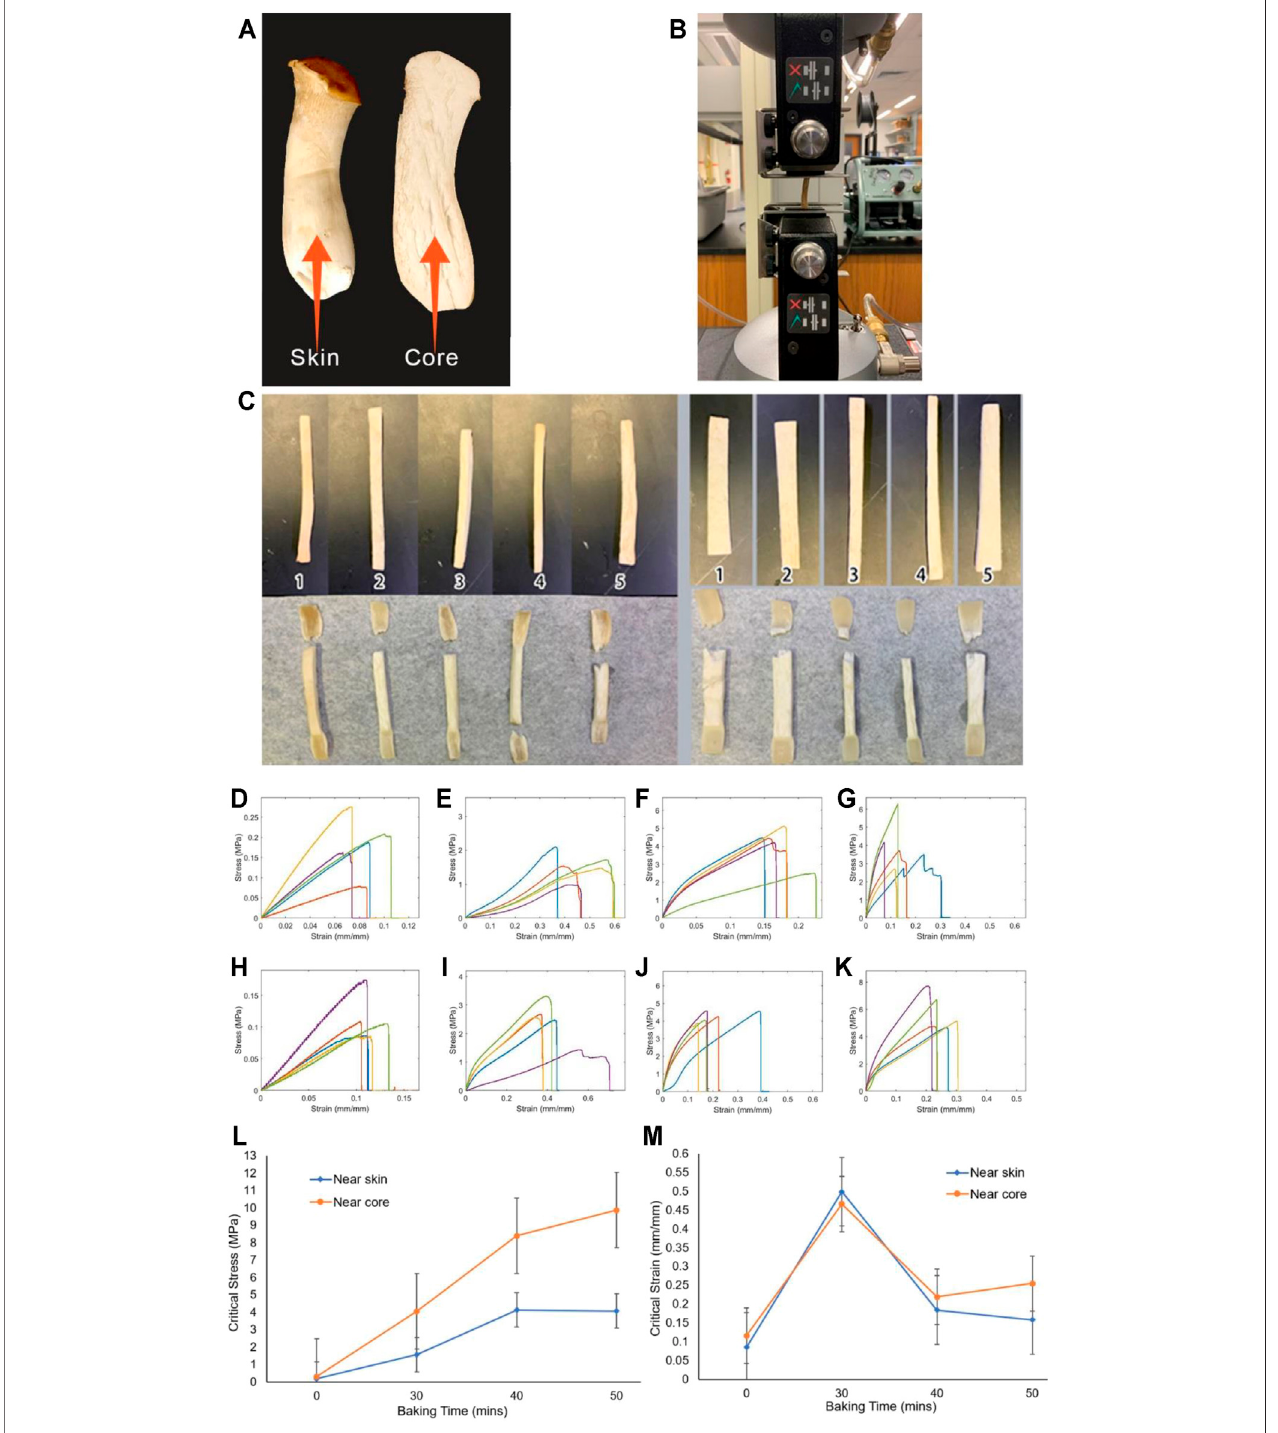
FIGURE 7 | Tensile tests of Pleurotus eryngii samples after low-temperature baking (A) . Snapshots of Pleurotus eryngii mushroom and the location where we obtaintheskinandcoresamples (B) .SnapshotoftheInstronmachinefortensiletest (C) .Thenatural Pleurotuseryngii (withoutbakingandwaterloss)neartheskin (left) and core (right) samples before (upper) and after (lower) the tensile test (D – G) . Stress-strain curve of different baking time ofsamples near the skin, with baking timeof 0, 30, 40, and 50 min, respectively (H – K) . Stress – strain curve of different baking times of samples near the core, with baking time of 0, 30, 40, and 50 min, respectively (L) . Critical stress of king oyster mushrooms as a function of baking time for samples at skin and core (M) . Critical strain of king oyster mushrooms as a function of baking time for samples at skin and core.